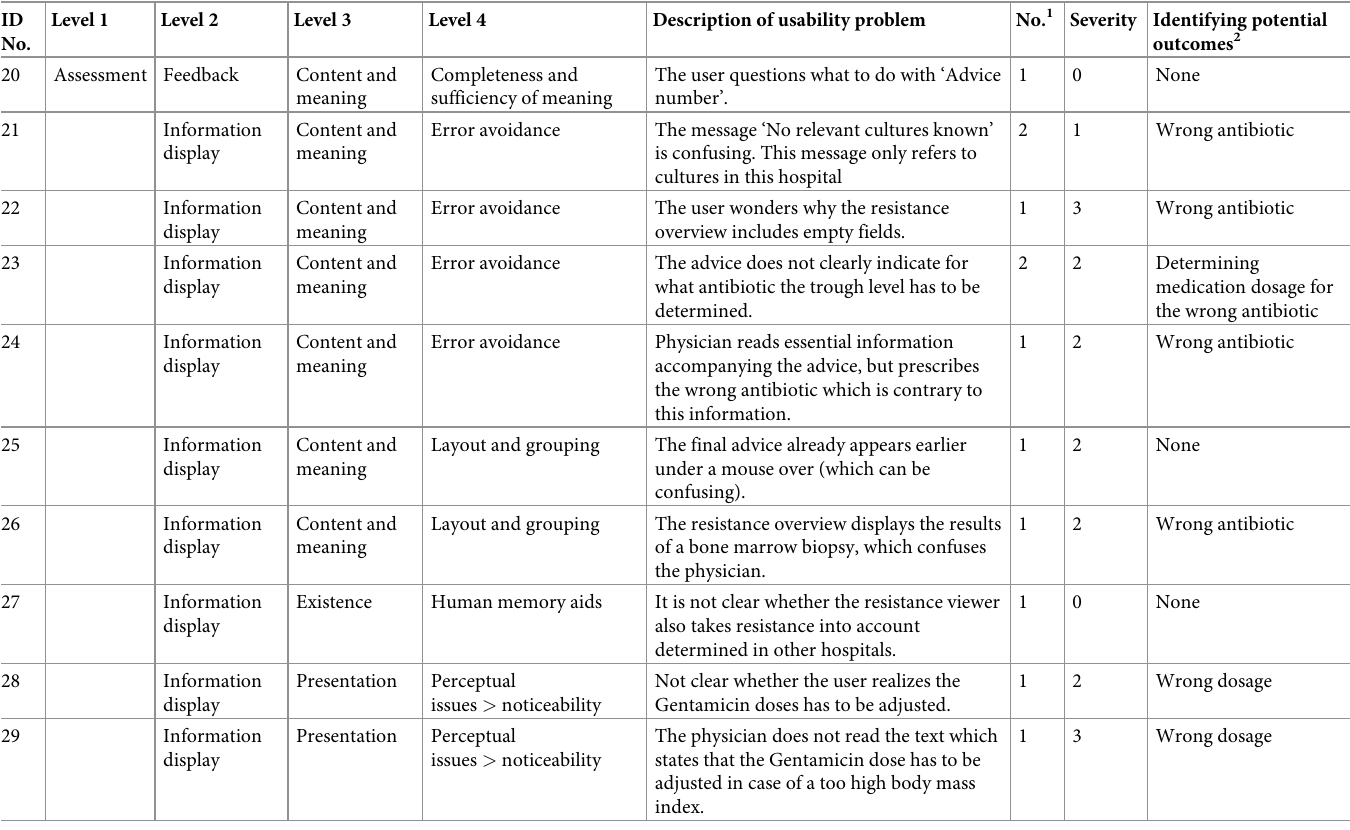
Table 4. Usability problems in the UAF assessment phase with their severity and potential effect on task